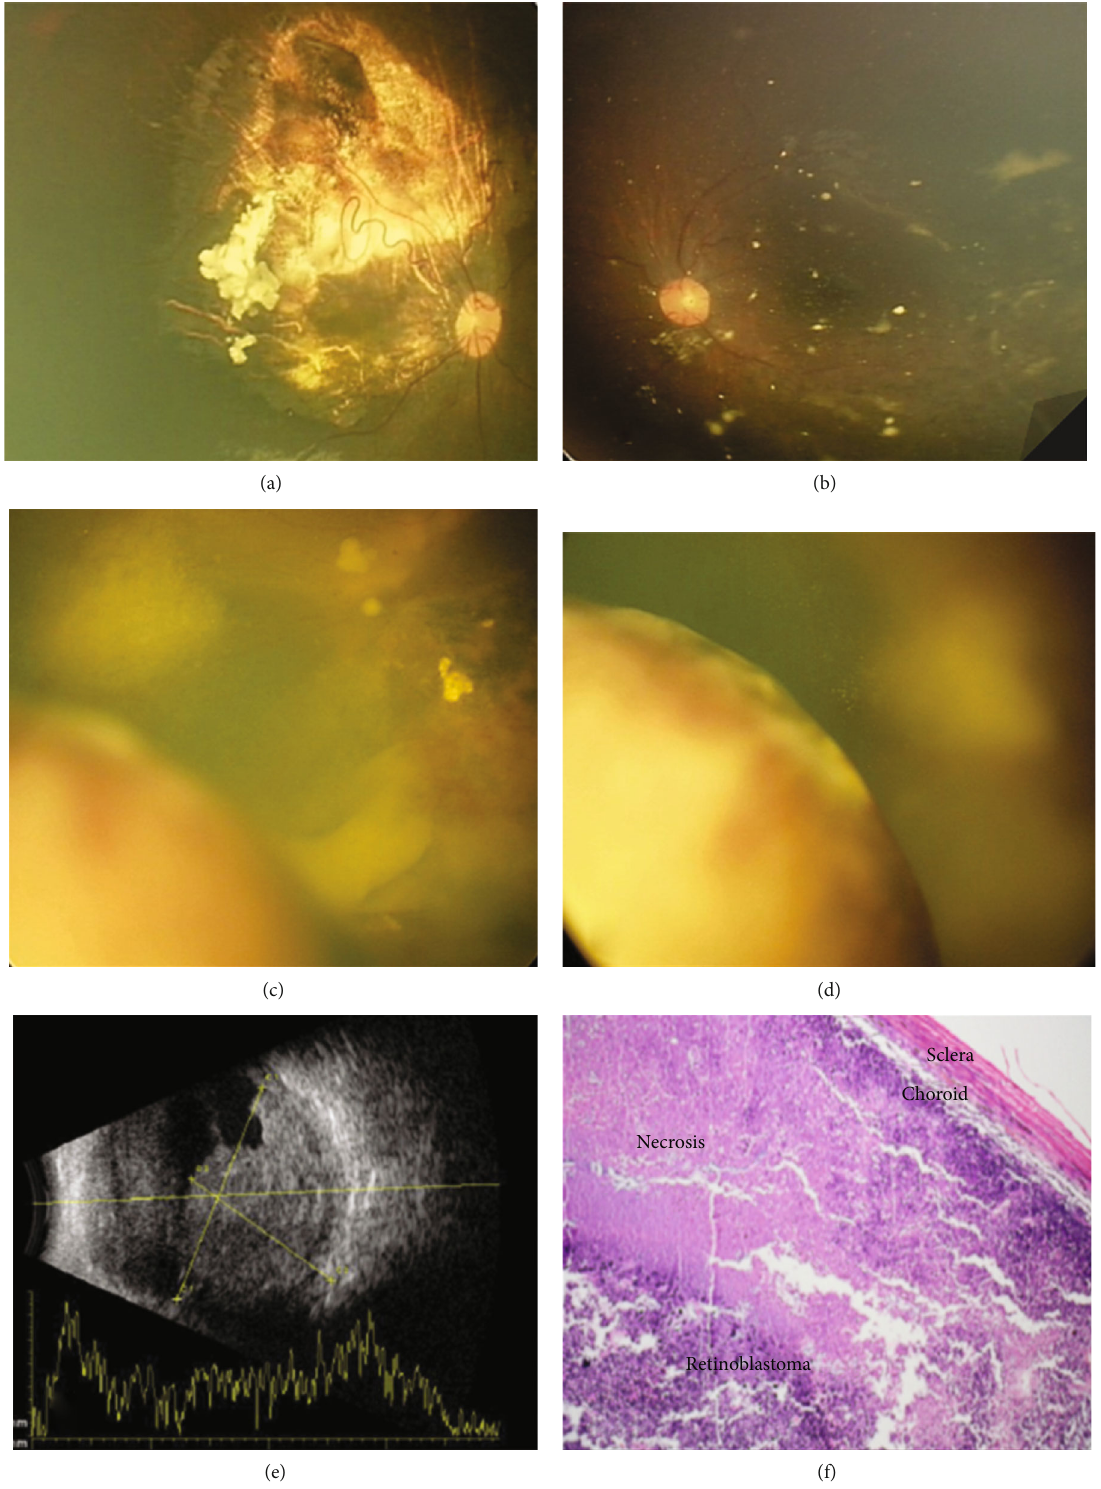
Figure 1: Fundus photograph of the right eye after 16 sessions of systemic chemotherapy demonstrating signi fi cant response to treatment (a). In the left eye, fundus photograph shows multiple chorioretinal scars with scattered calci fi ed vitreous seeds (b). Four months later, fundus pictures revealed a dome-shaped yellowish mass with overlying serous retinal detachment in the left eye (c). Two weeks later, there was signi fi cant lesion growth (d). Left eye B-scan ultrasonography reveals a huge underlying choroidal mass measuring 20 × 14mm without any highly re fl ective foci (e). Photomicrograph of globe lesion, in lower magni fi cation, shows massive choroidal invasion invading the whole thickness of the choroid which extended to the sclera (hematoxylin-eosin, × 40)